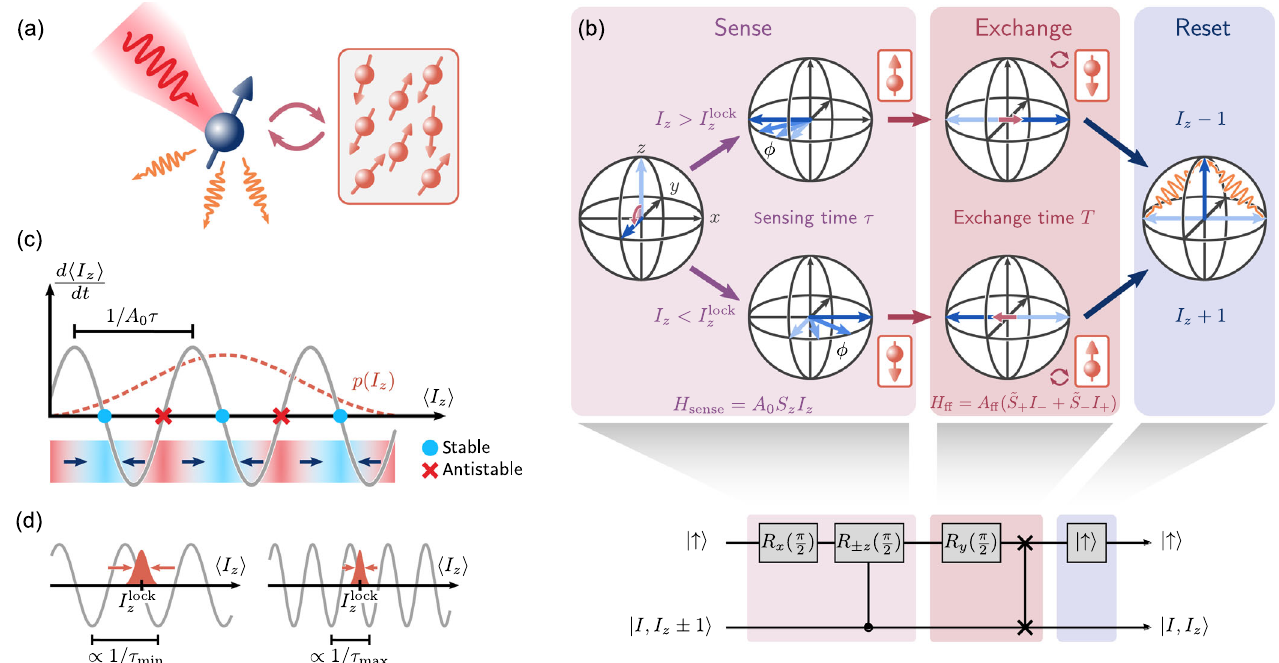
FIG. 1. Quantum-algorithmic feedback. (a) Pulsed control (red shading) of a central spin (blue), homogeneously coupled to a spin ensemble (red), can purify the state of the system, removing entropy via spontaneous scattering (orange). (b) The feedback algorithm. Top: Bloch sphere representation of the electron-spin evolution during one algorithm cycle. The upper (lower) path represents the case of a positive (negative) Δ I z . Bottom: quantum circuit representation of the feedback algorithm operating in the single-spin limit. The upper and lower rails represent, respectively, the central spin and the fj I; I z (cid:3) 1 i ; j I; I z ig states of the spin ensemble. (c) The rate of change d h I =dt as a function of h I t ≫ τ þ T , displaying multiple (anti)stable setpoints z i z i (gray curve) on a coarse-grained evolution time arising from the 1 =A 0 τ periodicity of the sensing gate. The red dashed curve represents the initial thermal probability distribution. (d) To purify an initially broad distribution (left, red shaded area) to a narrow single mode centered around I lock z (right, red shaded area), we to τ increase the sensing time dynamically from τ min max